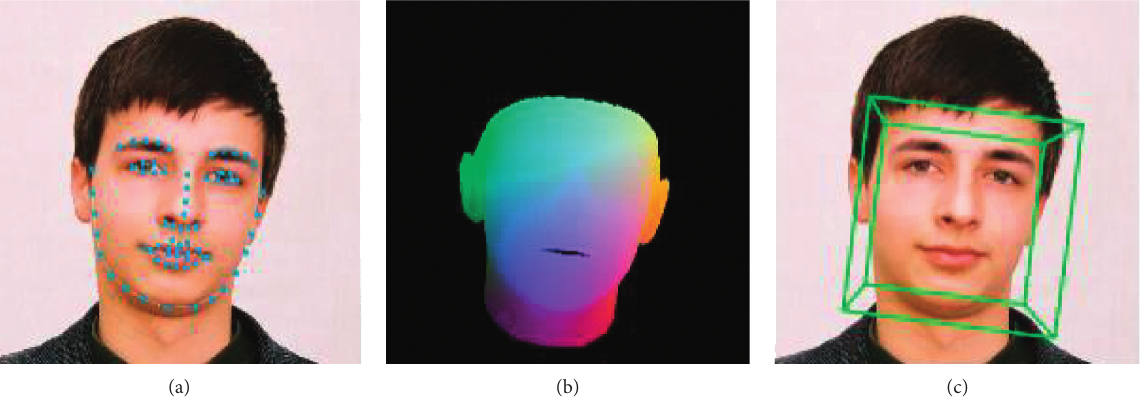
Figure 7: [0 ° , 30 ° ], small-pose face alignment results.